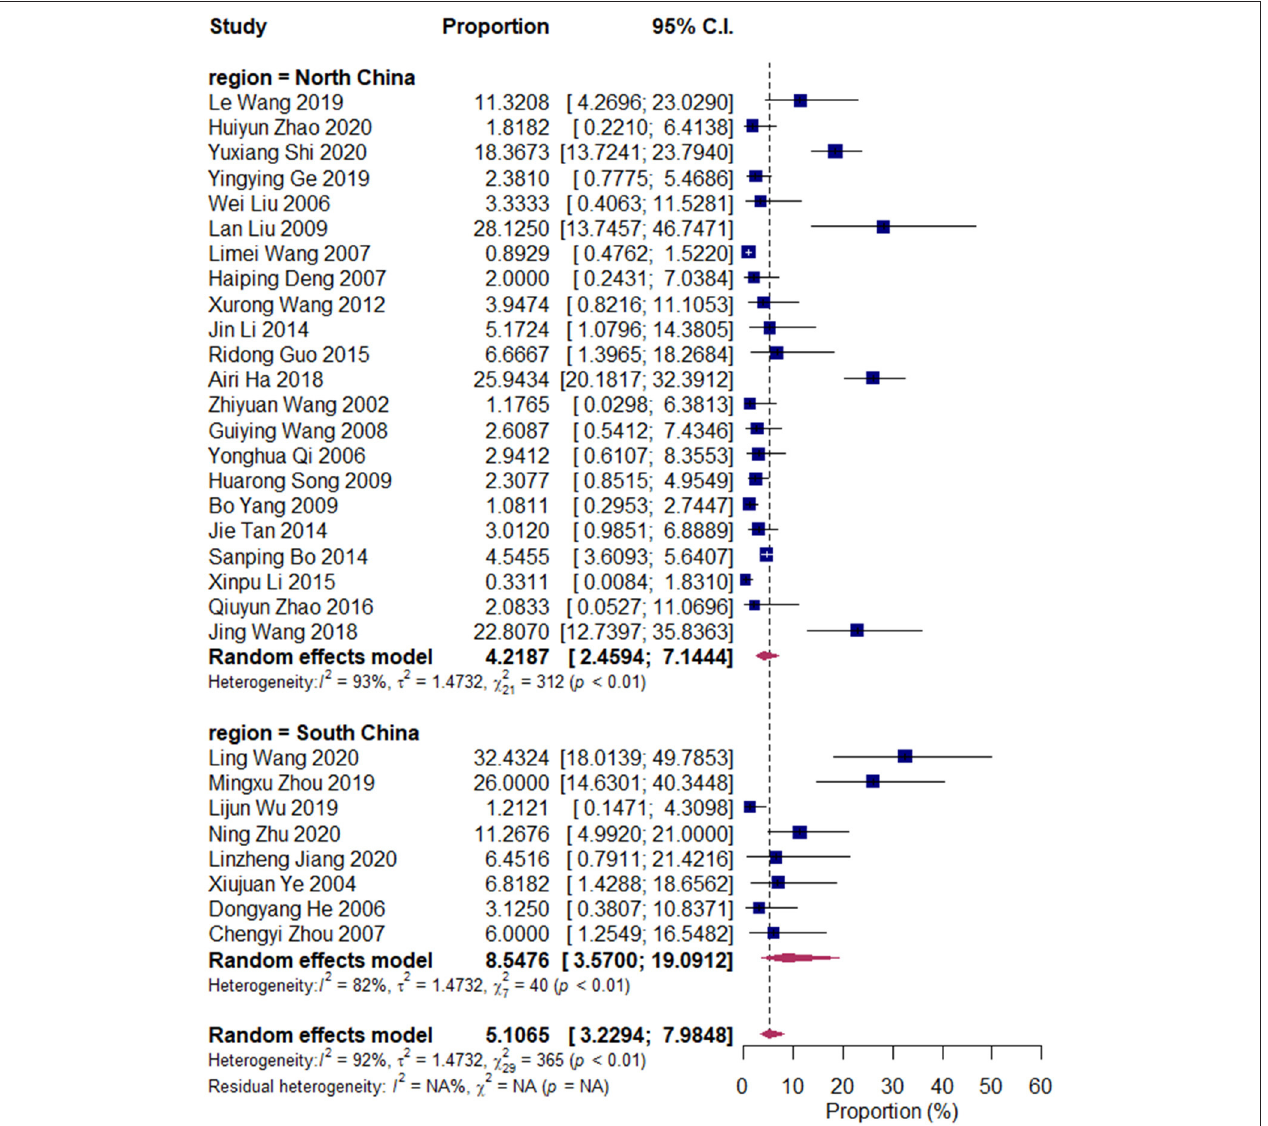
FIGURE 3 | Prevalence of Klebsiella spp. in North and South China. Subgroups were created according to the sampling region in China (North China/South China). The two upper diamonds represent the overall prevalence within the respective subgroups, whereas the diamond at the bottom represents the overall prevalence of all studies (the same